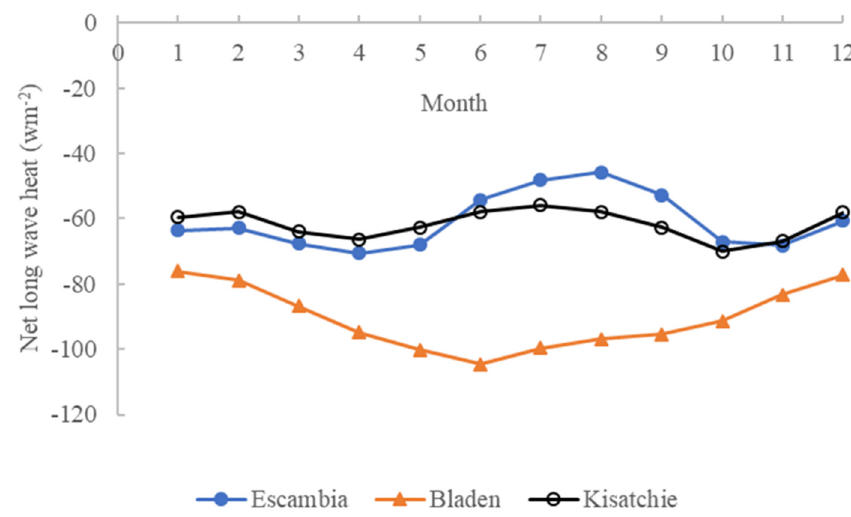
Figure 14. Dynamics of the integrated monthly net longwave in the three